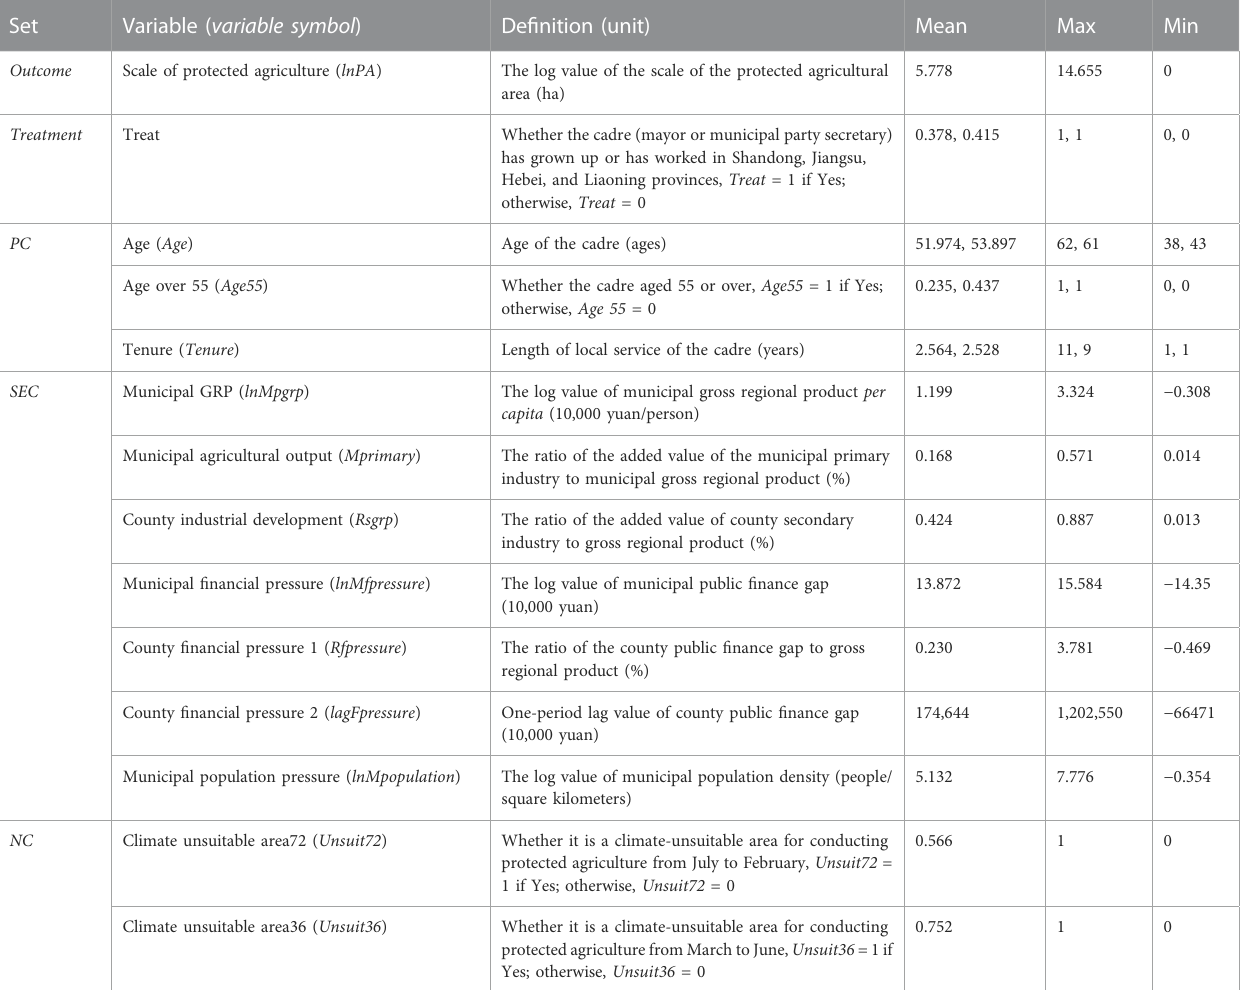
TABLE 1 Variables description and summary